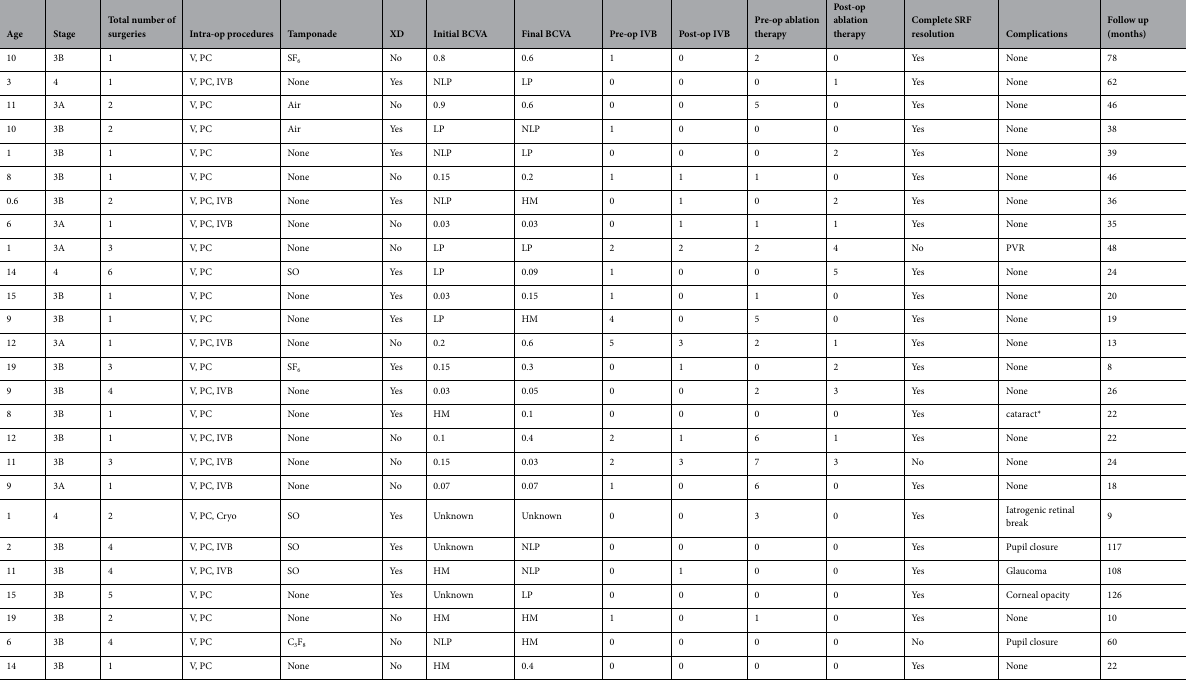
Table 1. Baseline characteristics, treatment course, and the functional and anatomical outcomes. M; male; F; female, SRF; subretinal fluid, IVB; intravitreal bevacizumab injection, V, vitrectomy, PC; laser